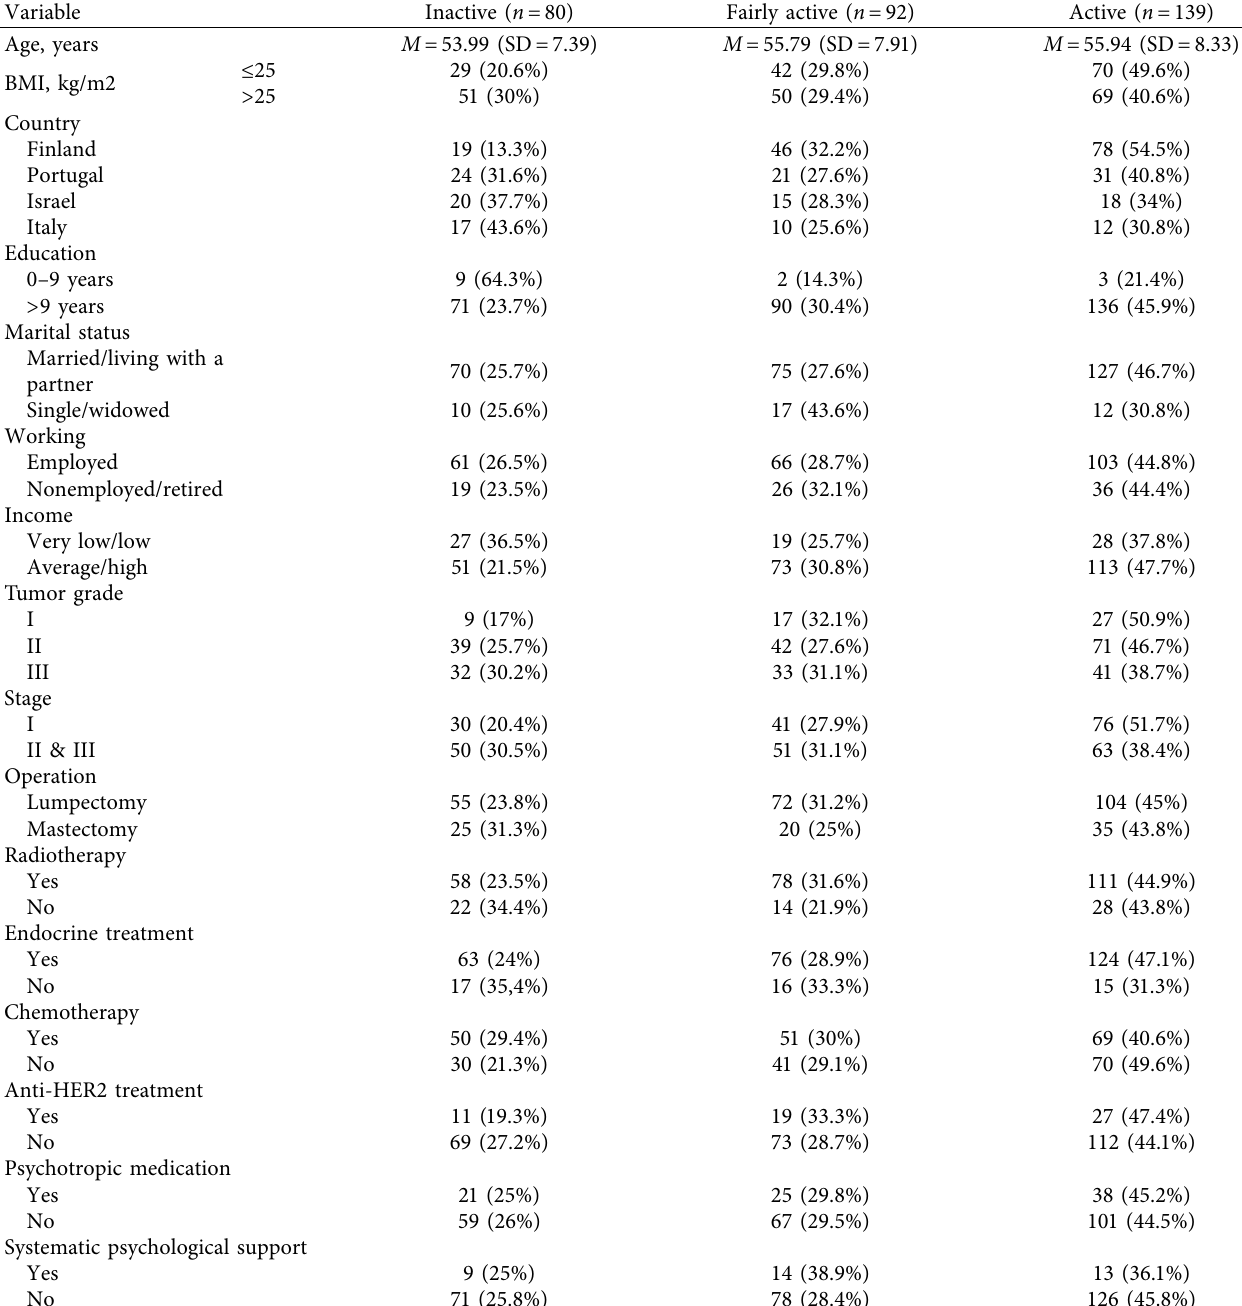
Table 2: Exercise habits at month 12 according to sociodemographic and medical variables ( Ν �